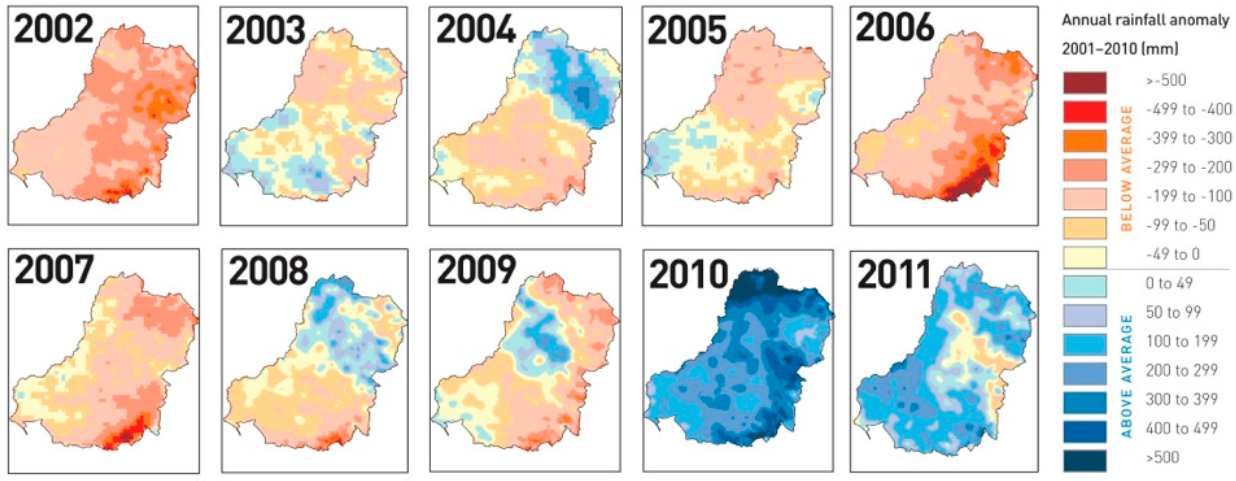
Figure 3. Rainfall “anomalies” 2002 to 2011 in the MDB [87].